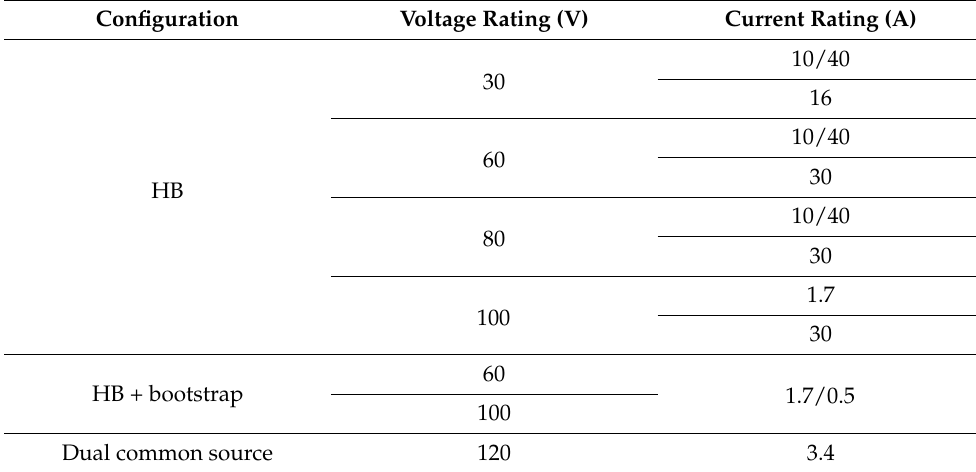
Table 13. Commercial GaN HEMT modules by EPC.